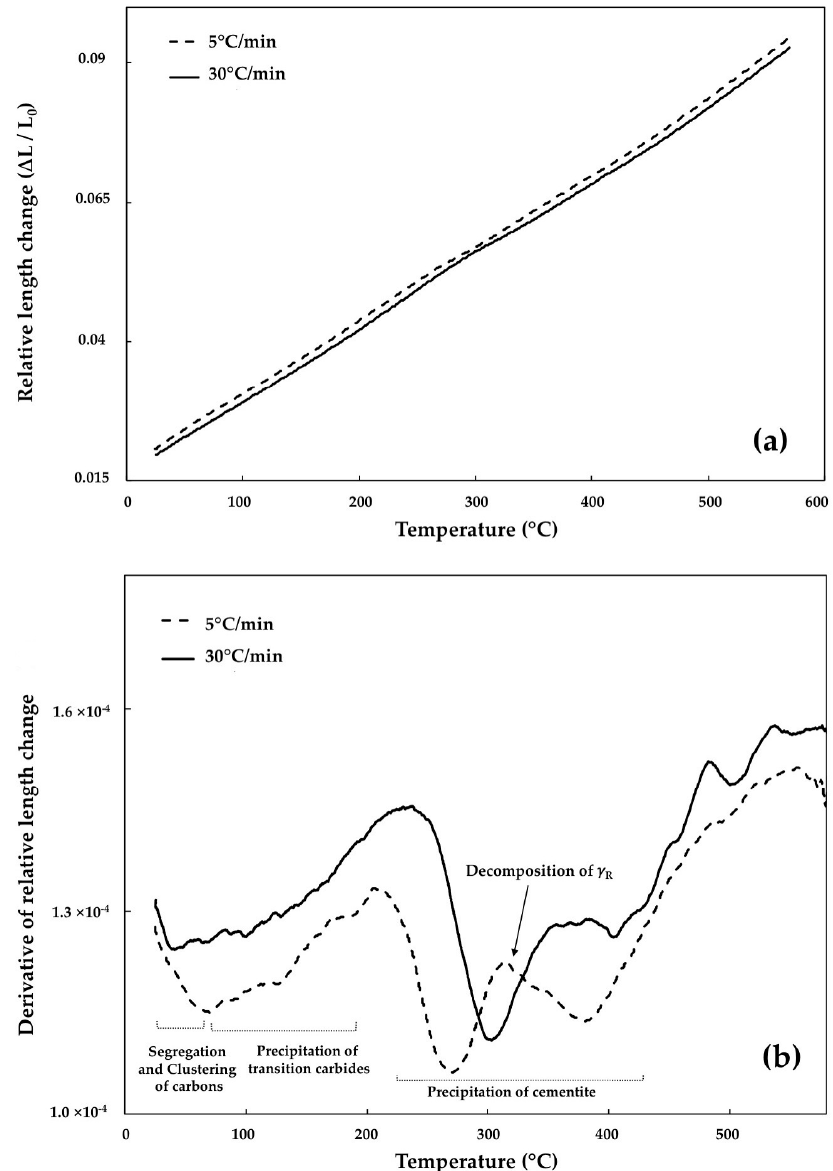
Figure 4. ( a ) Relative length change diagram during non-isothermal tempering of the martensitic specimen at the heating rates of 5 °C/min and 30 °C/min, and ( b ) the first derivative curve of relative length change corresponding to these heating rates.